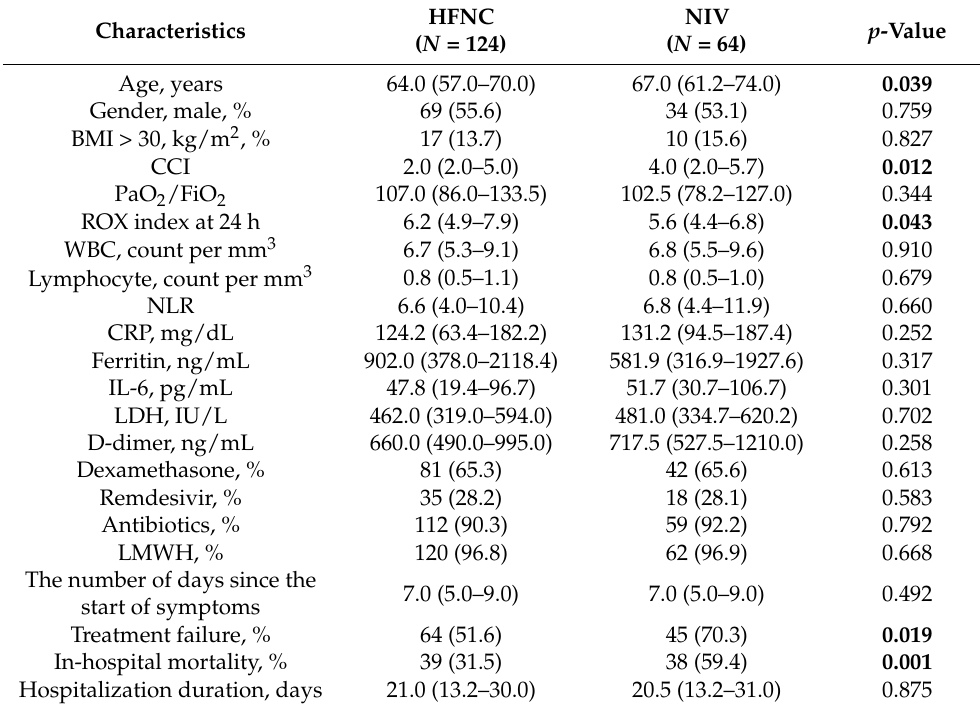
Table 1. Patients’ characteristics and results differed depending on their therapy